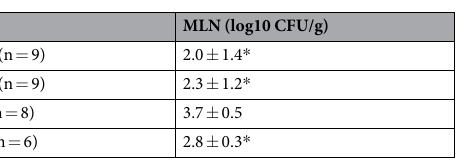
Table 2. Effects of pretreatment with B. pseudocatenulatum LI09 or B. catenulatum LI10 on bacterial translocation during D-GalN-induced acute liver injury. Values are expressed as the mean ± SD. * p < 0.05 compared with the PC